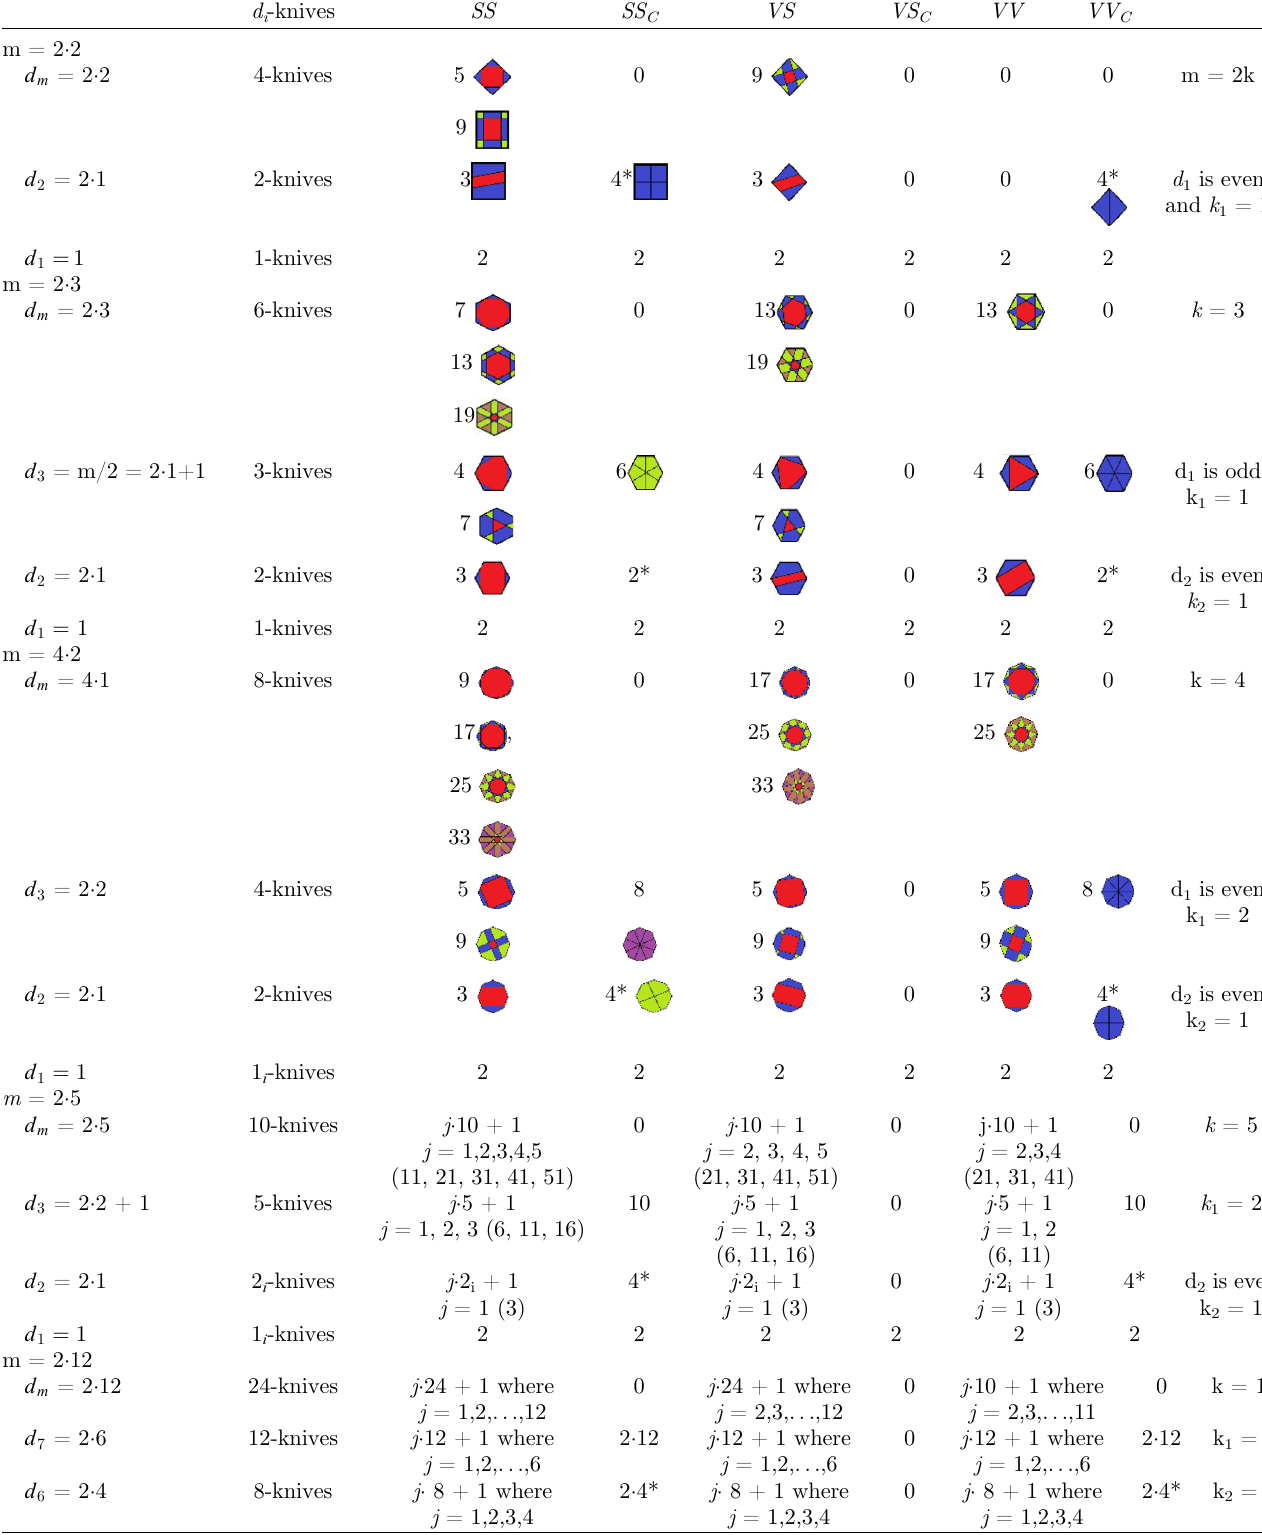
bodies for even m = 4, 6, 8, 10, m